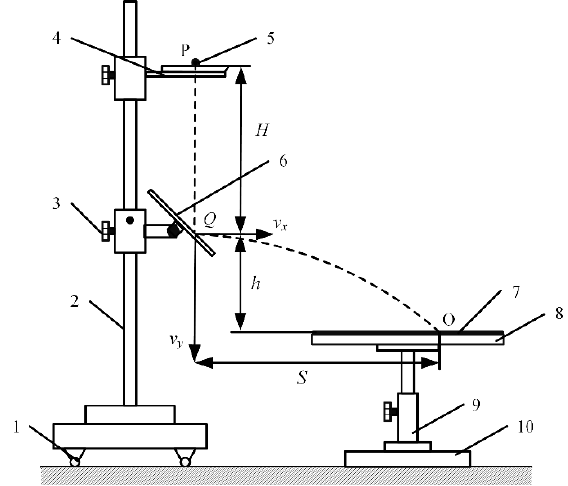
Figure 4. Schematic diagram of the restitution coefficient test device and test principle. 1, Legs; 2, support rod; 3, locking screw; 4, feeding frame; 5, material particles; 6, collision plate; 7, buffer box; 8, material collection plate; 9, retractable column; 10, fixed base. Note: P—Feeding reference point; Q —Collision point; O—Particle drop point on the buffer box; H —Particle drop height before collision, mm; h —vertical height from collision point Q to particle drop point, mm; S —The average horizontal throwing distance of the particle after collision, mm; v x —The partial velocity of the particle in the horizontal direction after collision, m/s; v y —The partial velocity of the particle in the vertical direction after collision, m/s.